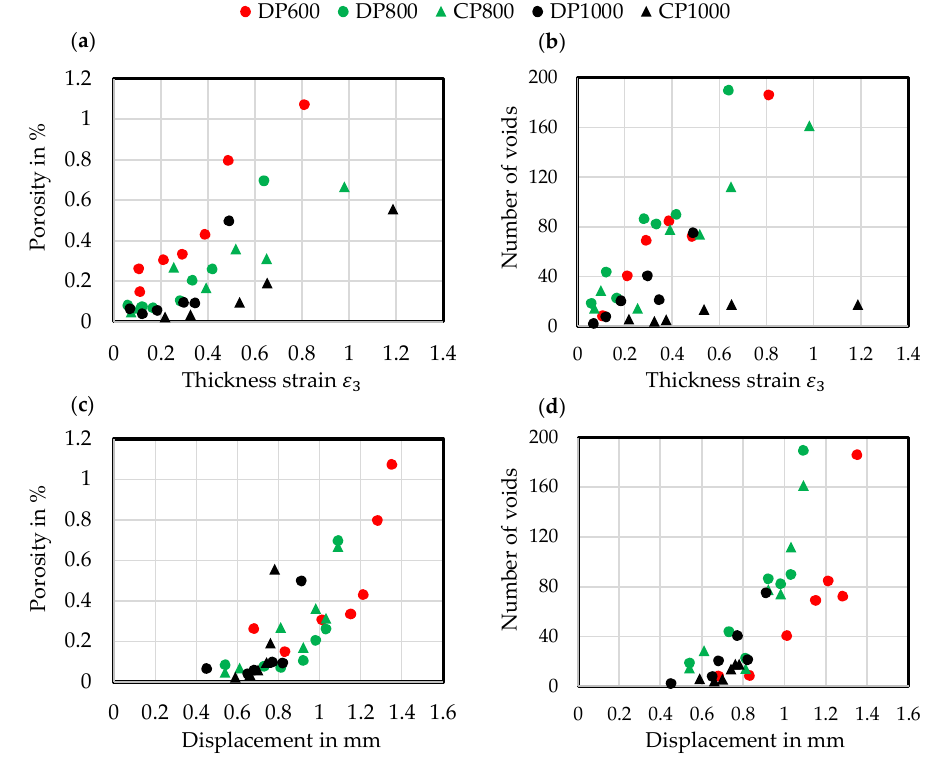
Figure 8. Notched tensile test: ( a ) Porosity–Thickness strain diagram; ( b ) Number of voids–Thickness strain diagram; ( c ) Porosity–Displacement diagram; ( d ) Number of voids–Displacement diagram.